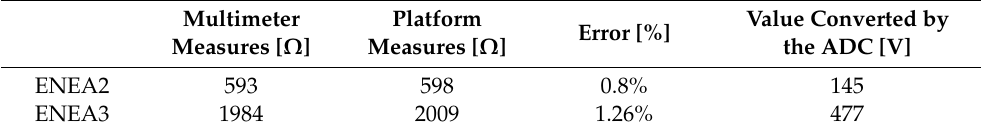
Table 11. Summary of the main electrical parameter checked after the connection to the CEA-LETI platform.